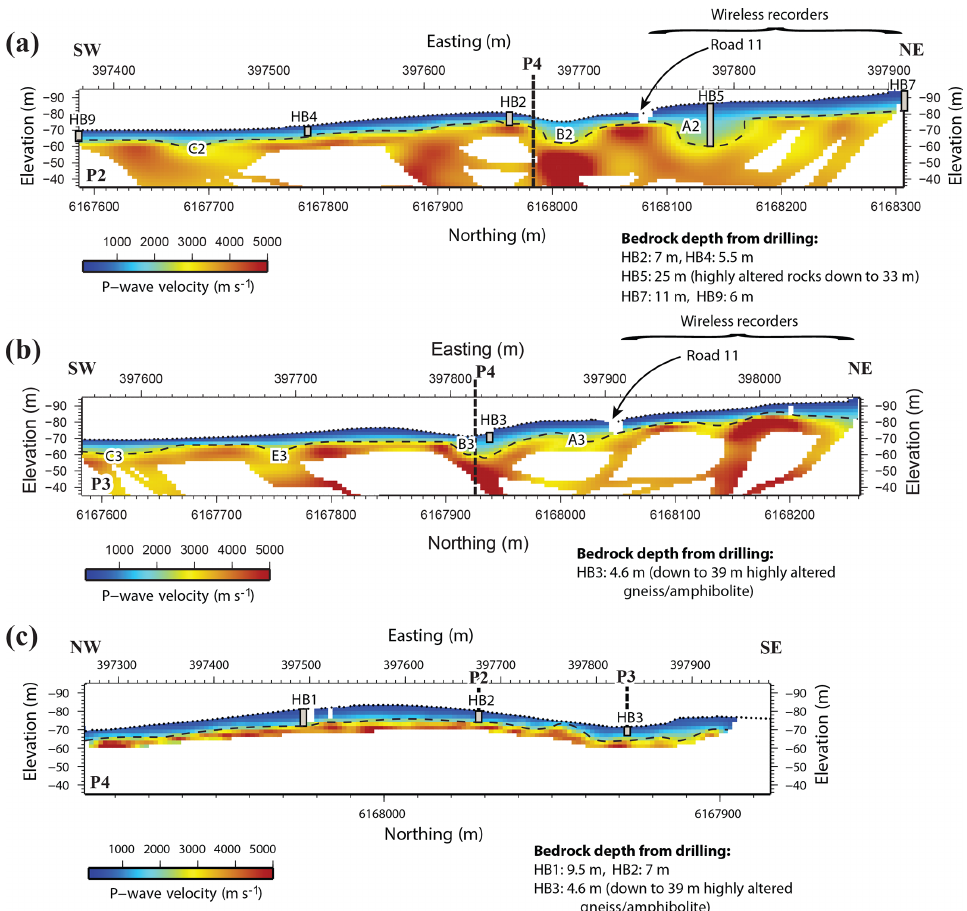
Figure 9. First break travel-time tomography model along (a) profile 2, (b) profile 3 and (c) profile 4, showing the undulating nature of bedrock (dashed line) and correlation with the bedrock surfaces identified from follow-up drilling at the site. Low-velocity depressions are notable in areas labeled by A2–3, B2–3, C2–C3 and E3 particularly along profile 2. The poorest quality rocks and deepest bedrock were observed at the location of A2 (HB5), where down to 33m depth only highly altered rocks were observed from the drill cuttings (i.e., no core drilling was